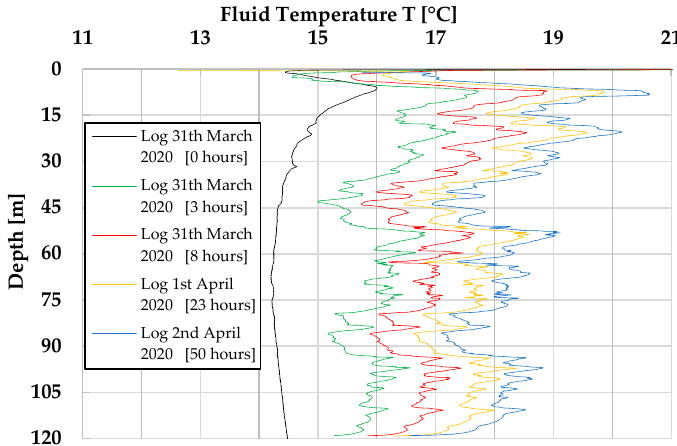
Figure 11. Distributed Thermal Response Test (TRT) experiment at the ASC site after the complete decay of any hydration effect. Vertical temperature profiles along the BHE depth during a 50 h experiment at a constant heat transfer rate. Table 1. A selection of the dataset containing all the measured temperatures in time and space. Column A and B are the Infinite Line Source (ILS) model estimations for the slope and intercept, respectively (Equation 5), as obtained by log-linear regression for each row. Columns k gr and R bhe are the estimates for the ground and BHE properties as solutions of Equation (7) applied to each row. Depth